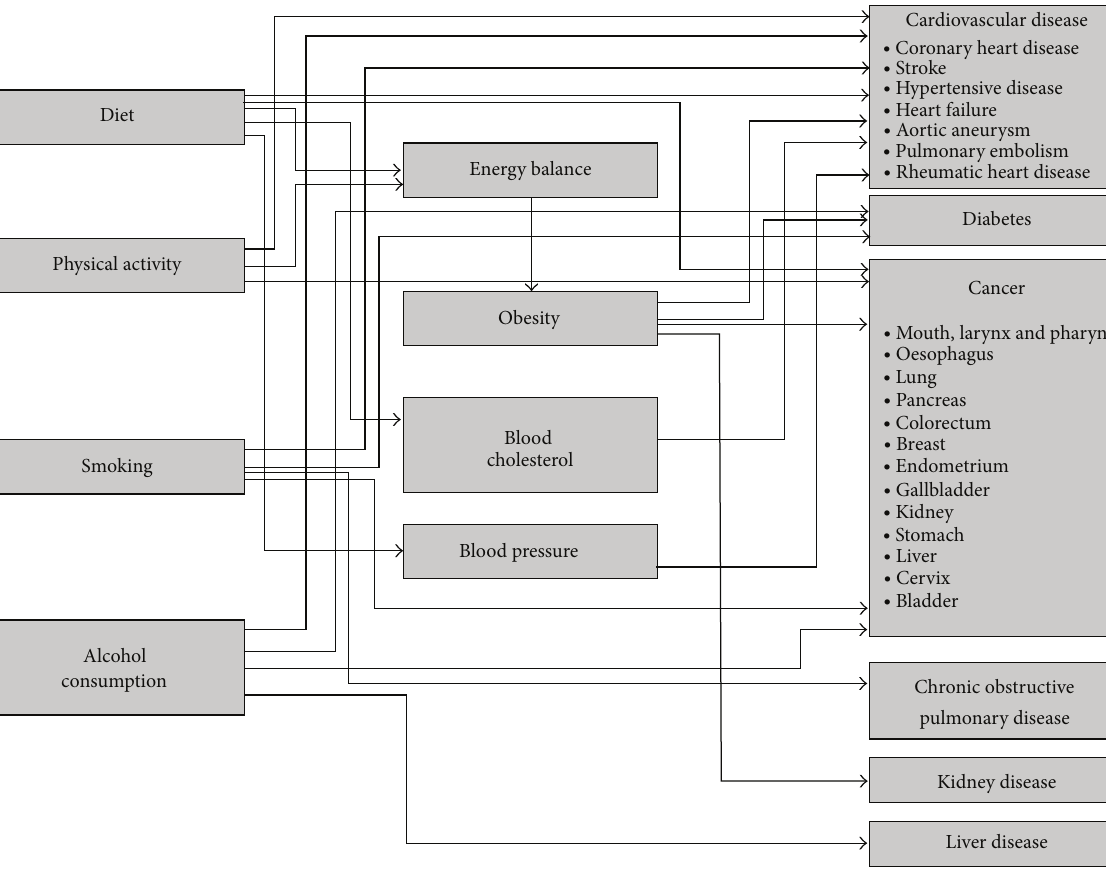
Figure 1: Schematic diagram of the